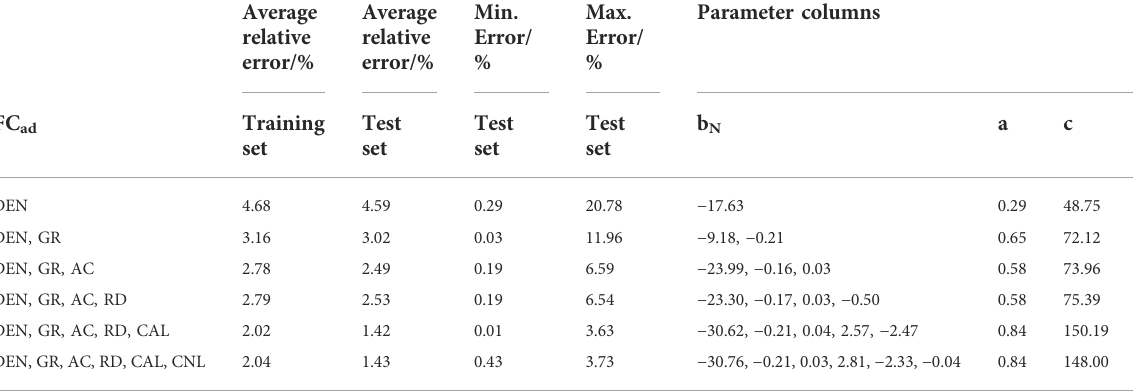
TABLE 3 Performance and parameters of the FC ad content prediction models under different logging curves.